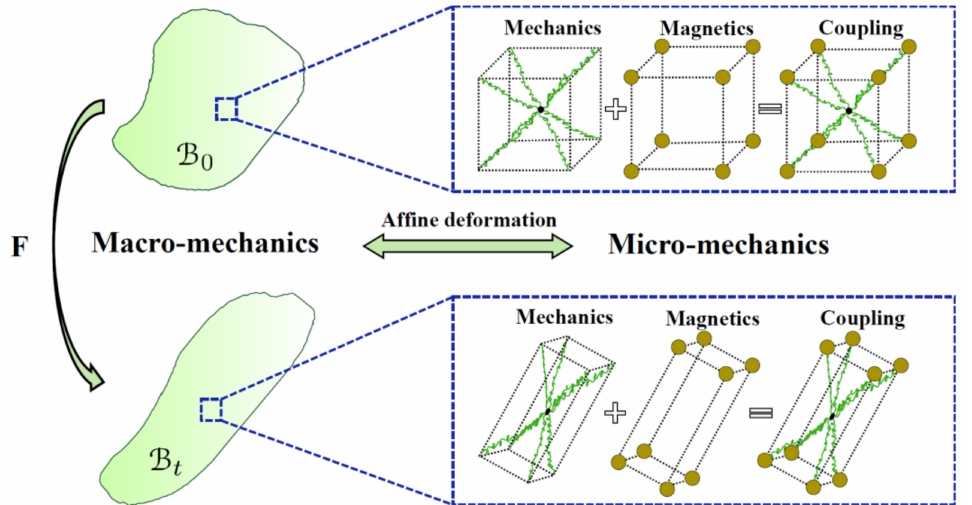
Figure 3. Scheme of microstructural-based approach, accounting for both magnetic particles and polymer matrix components, and how these models can be scaled up to the micromechanical level. Figure adapted from Garcia-Gonzalez and Hossain